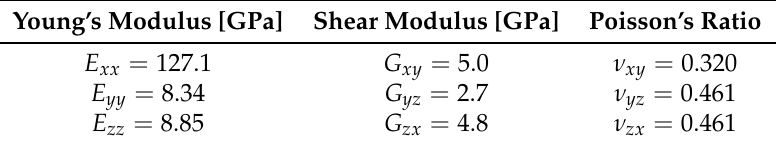
Table 1. Material properties of the T300/924C